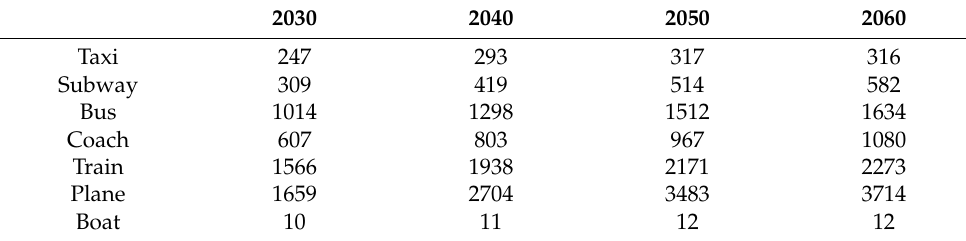
Table 2. Demand for passenger transport (billion